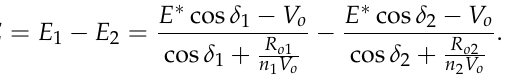
Figure 7. Conventional droop control method. By replacing Equation (15) in Equation (13), the active power is calculated